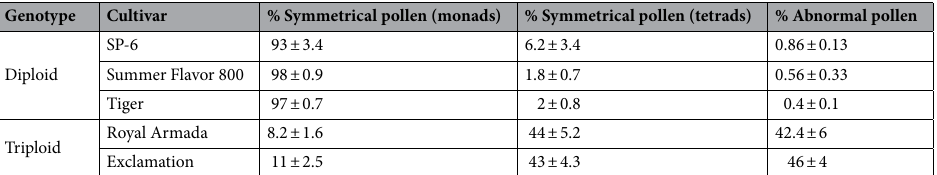
large irregular-shaped pollen grains (> 100 μm) (Fig. 2f–i), pollen grains with less developed exine characters, smooth surfaces, or irregular-shaped solid structures (Fig. 2j–m, Supplementary Fig. S3). Pollen size varied among cultivars [surface area (F 4, 25 = 32.26), perimeter (F 4, 25 = 26.2), polar axis (P) (F 4, 25 = 28.8), equator diameter (E) (F 4, 25 = 34.65), P < 0.001, Supplementary Table S1 and S2] and genotypes [surface area (F